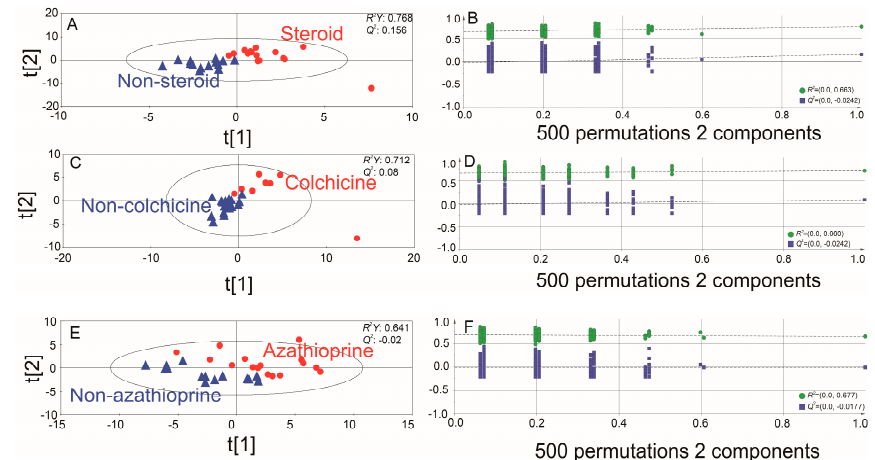
Figure 2. Score plots of the partial least square-discriminative analysis (PLS-DA) models ( A , C , E ) and 500 permutation tests using 2 components of the PLS-DA model ( B , D , F ). These models were generated